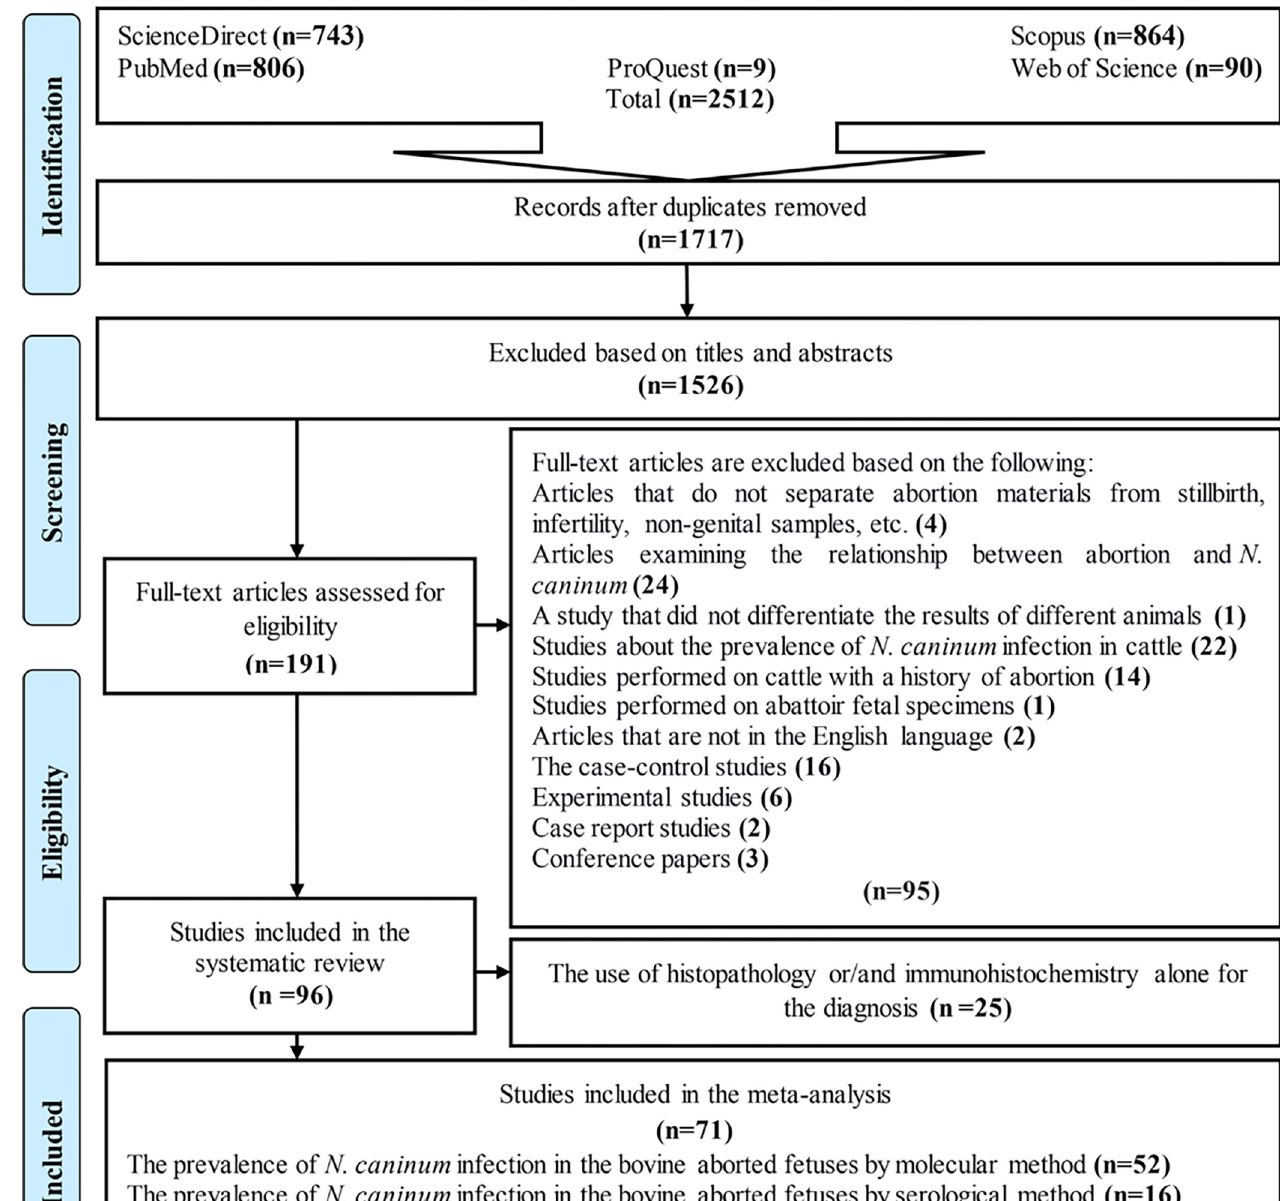
Fig 1. Flow diagram of the study design